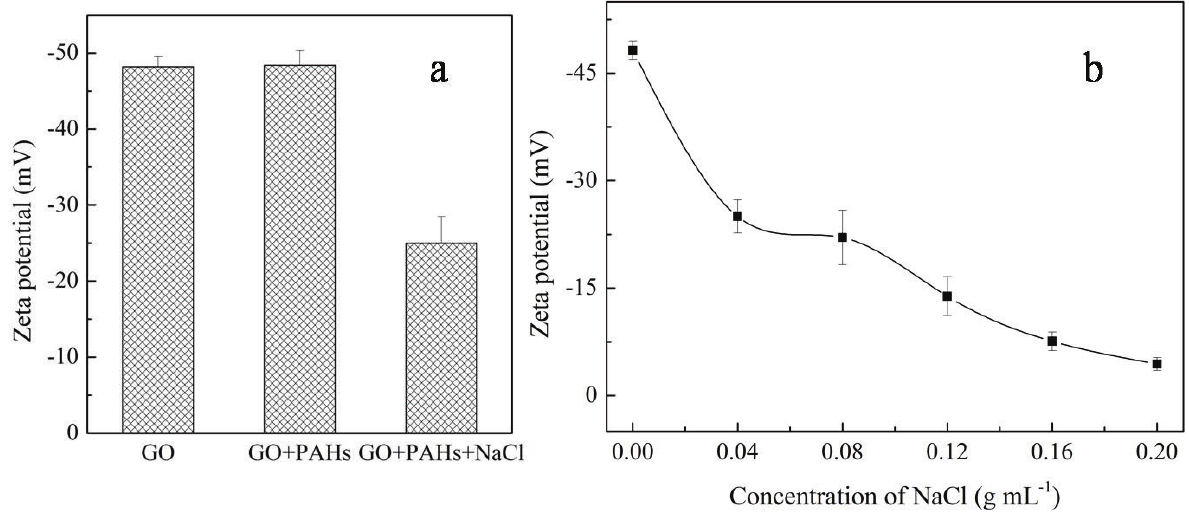
Figure 2: Zeta potential measurement of GO suspensions: (a) Zeta potential values after addition of PAHs (1000 µg mL -1 ) and NaCl (0.04 g mL -1 ) into GO suspensions (1 mg mL -1 ), and (b) Zeta potential of GO at 1 mg mL -1 as a function of